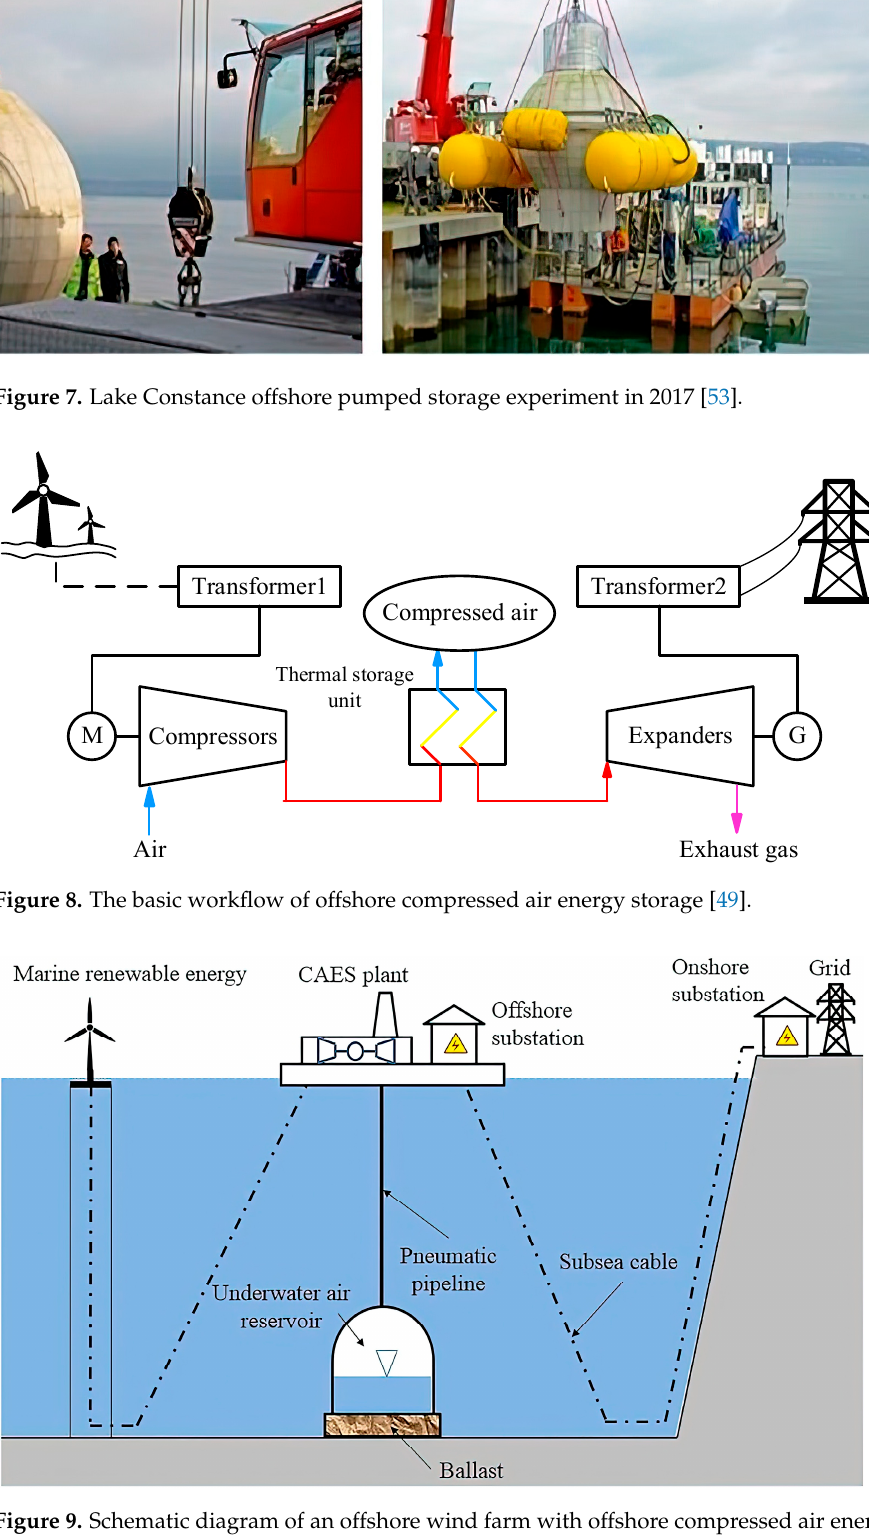
Figure 9. Schematic diagram of an offshore wind farm with offshore compressed air energy storage connected to the grid. CAES stands for compressed air energy storage [53].